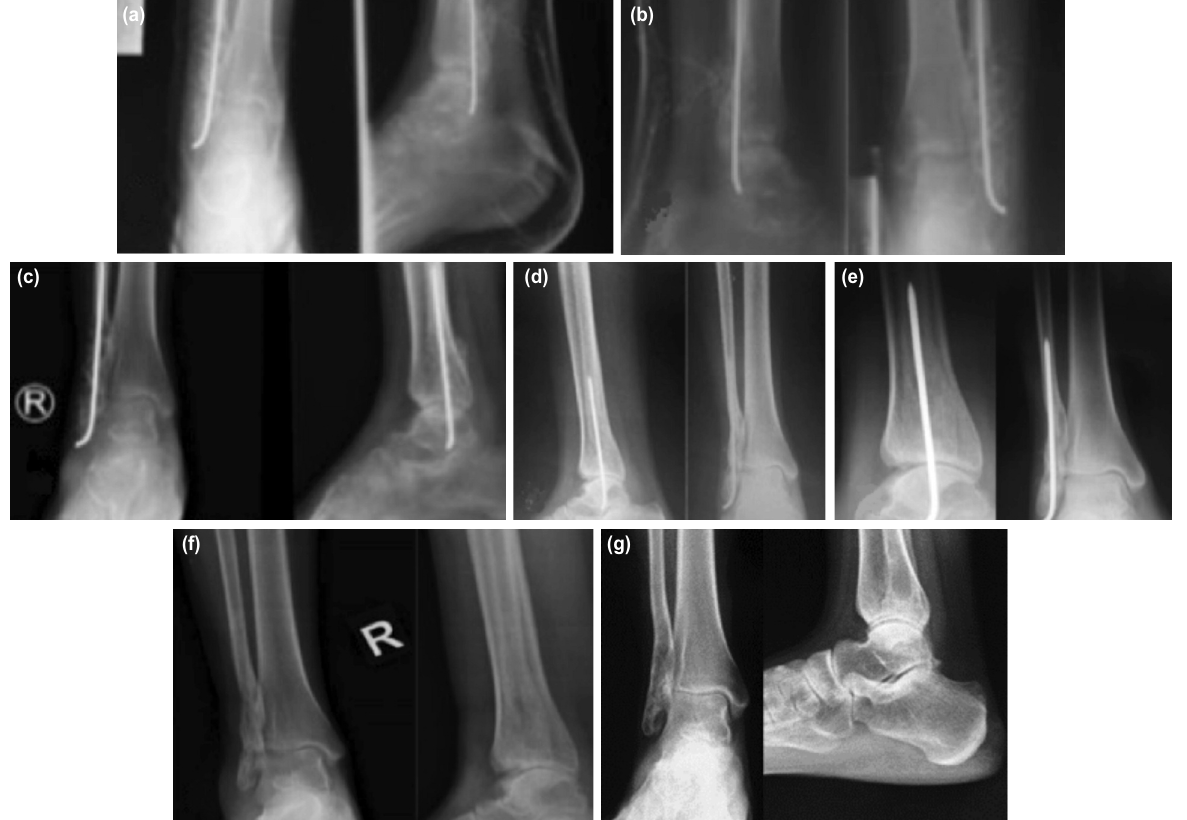
Outpatient consultations, (a) four weeks post-operative, (b) six weeks post-operative, (c) eight weeks post-operative, (d) seven Fig. 3: months post-operative, (e) nine months post-operative, (f) post removal of implant, (g) three years